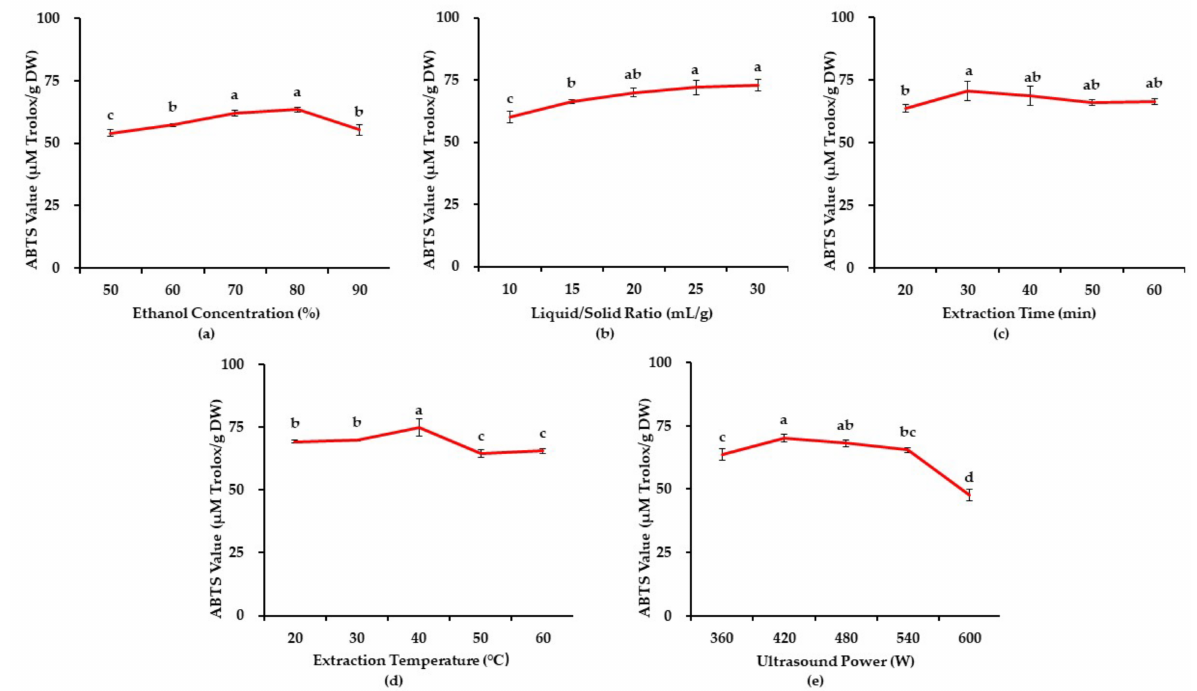
Figure 1. Effects of ethanol concentration ( a ); liquid/solid ratio ( b ); extraction time ( c ); extraction temperature ( d ); and ultrasound power ( e ) on ABTS-reducing capacities of ‘Jinfeng’ kiwifruit. Varying lowercase letters (a–d) indicate statistically significant differences ( p <